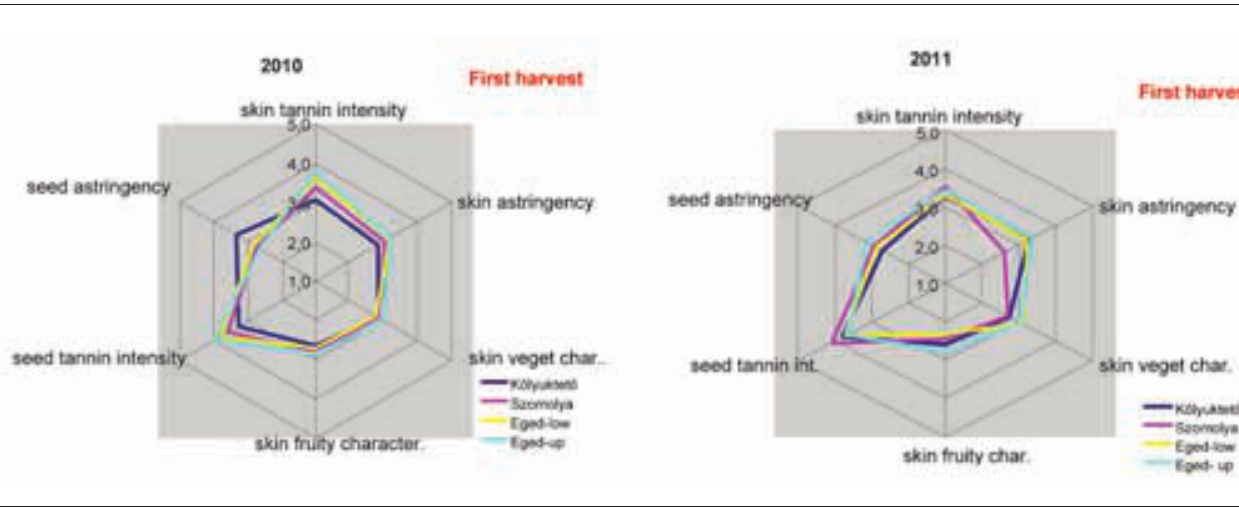
Figure 1 a: Main sensorial characters of the berry skin and the seeds (2010-2011- First harvest time)